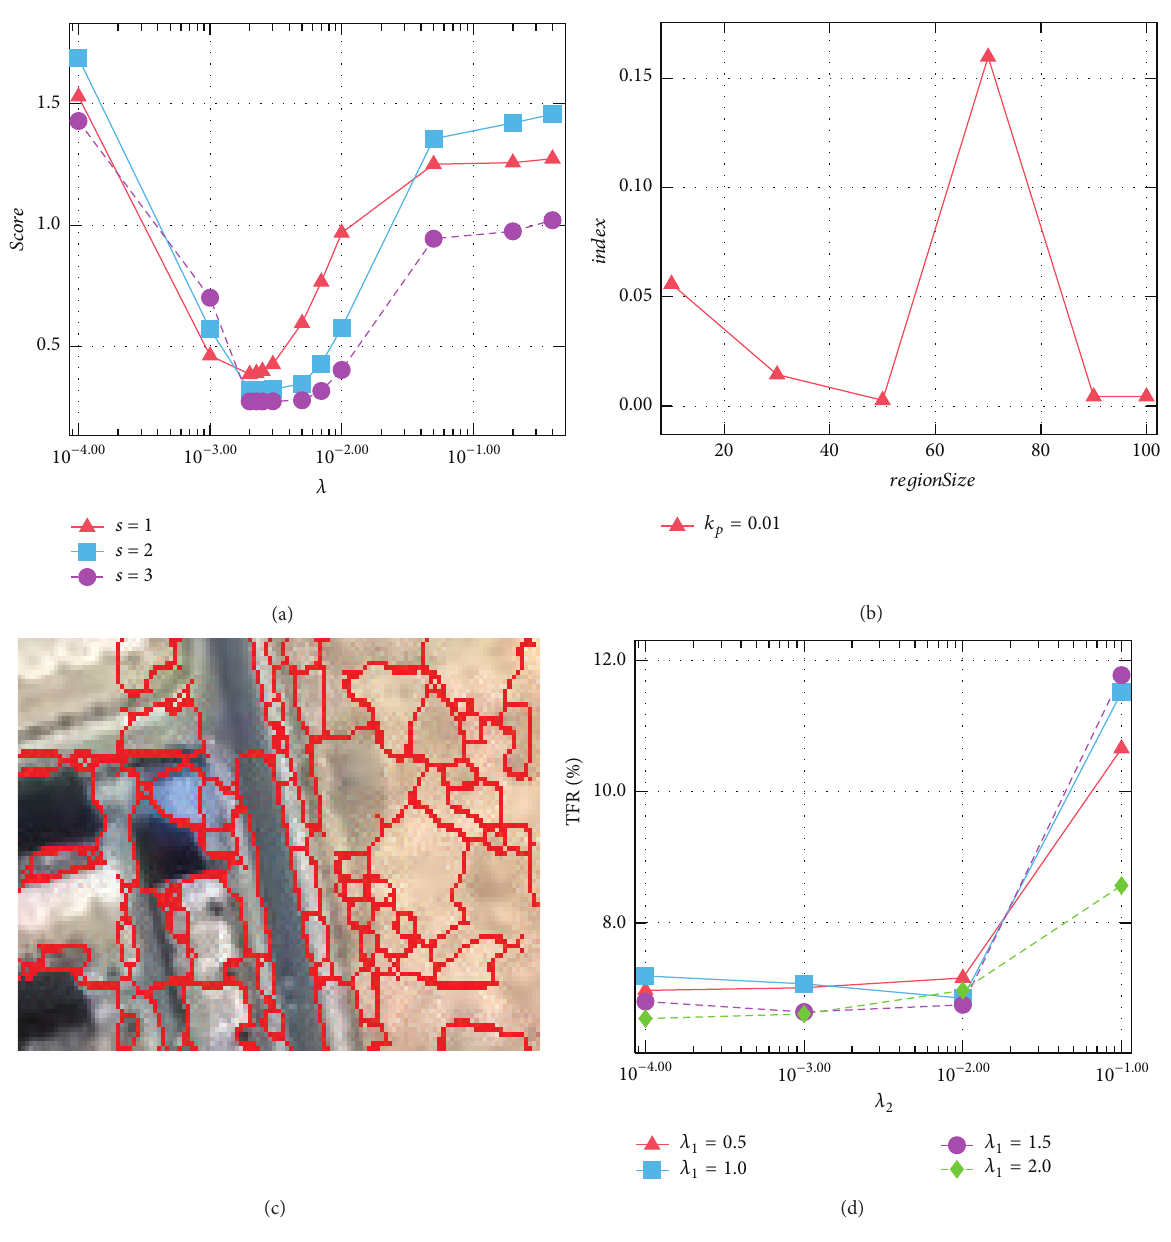
Figure 3: Parameter estimation on toy data set in Figures 2(a)–2(d) (a)–(c) and parameter sensitivity analysis on DS1 (d). (a) The 𝑠𝑐𝑜𝑟𝑒 - 𝜆 curves at three different scales. (b) The 𝑖𝑛𝑑𝑒𝑥 - 𝑟𝑒𝑔𝑖𝑜𝑛𝑆𝑖𝑧𝑒 curve at the scale 𝑠 = 1 . (c) The segmentation result of the image I by the best